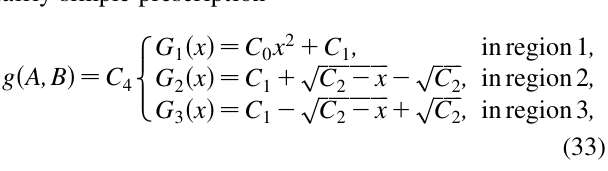
positive (solid red line) and negative (blue dashed line) values of ‘ . For the moment consider the defocusing (solid red line) case, which has ‘ > 0 . There are four values of A for which K (cid:1) 0 : 01 but the density g (cid:3) A; B (cid:4) need not have the same value at all four points. The key is the separatrix, on which K (cid:1) K , which is shown in s Fig. 10. In each of the three regions bounded by the separatrix one is free to choose a different functional form g (cid:1)